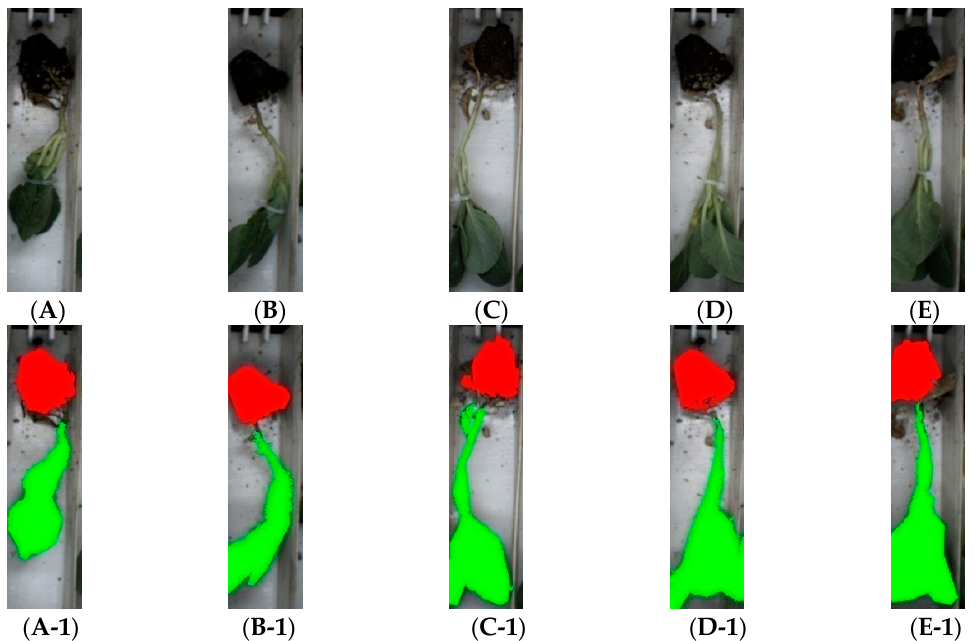
Figure 12. Image segmentation results based on maxIOU. ( A – E ) The original images; ( A-1 – E-1 ) the segmented images. The red regions are the segmented substrate regions. The green regions are the segmented seedling regions.